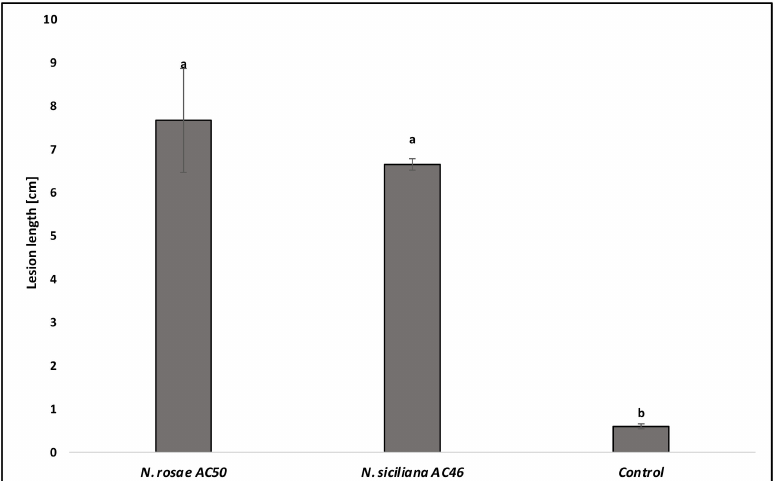
Figure 6. Comparisons of average lesion length (cm) resulting from pathogenicity tests among Neopestalotiopsis rosae and N. siciliana on potted plants. Columns are the means of 6 inoculation points (2 per plants) for each fungal species. Control consisted of 6 inoculation points. Vertical bars represent the standard error of the means. Bars topped with different letters indicate treatments that were significantly different according to Fisher’s protected LSD test ( α =